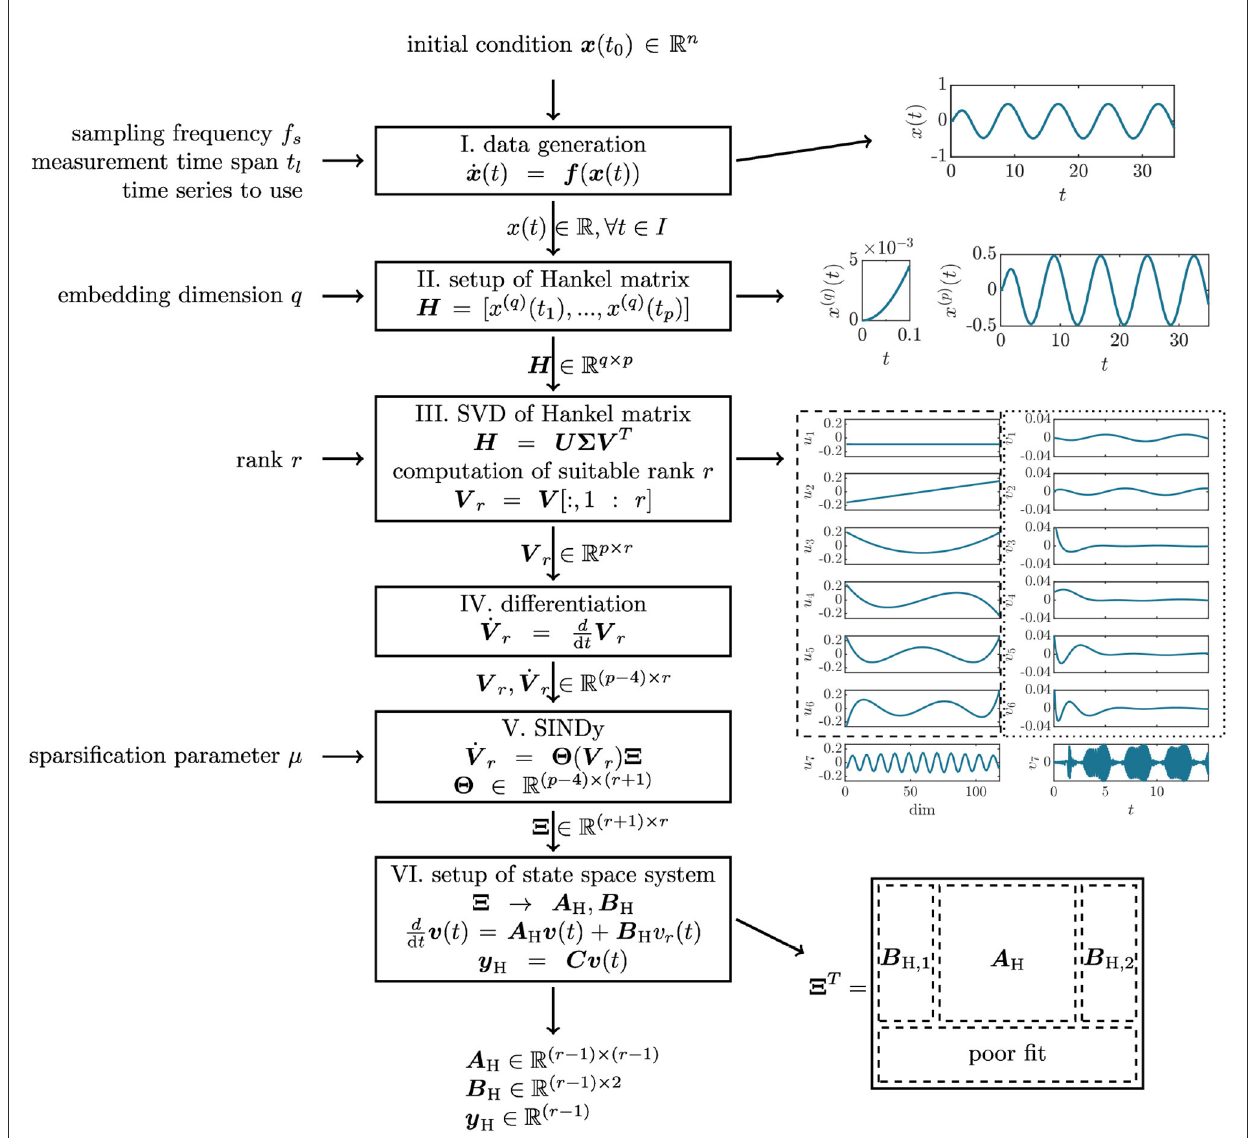
FIGURE2 The six steps of the HAVOK algorithm, the parameters, and exemplary images of the data processed in each step. The vertical flow-chart illustrates the six steps data-generation, setup of the Hankel matrix, singular value decomposition (SVD) of the Hankel matrix, differentiation, sparse regression using the SINDy algorithm, and finally the setup of the state space system. On the left, the tuning parameters for each step are introduced. The images on the right-hand side of the figure illustrate the data each step is concerned with. From top to bottom. (1) The time series x ( t ) generated is the first step. (2) The time series sections x ( q ) ( t ) and x ( p ) ( t ) that form a column and a row of the Hankel matrix H , respectively. (3) The results of the SVD, represented by columns u j and v j of the matrices U and V . The u j represents a coordinate system, while the v j represents the evolution of these coordinates in time t . (4) The state space matrices A H and B H are setup by dividing up the matrix of sparse coefficients 4 . The bottom row of 4 is dropped as it represents a poor fit. Each step is described in detail in the respective section of the methods part of this